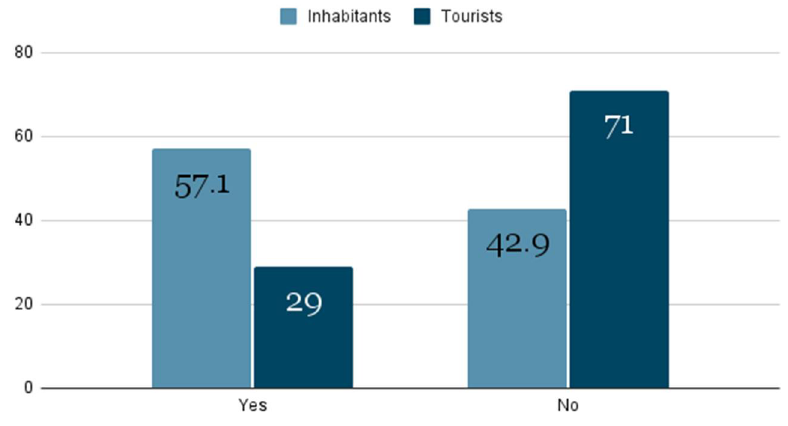
Figure 7. Identification of the Malaga brand. Source: own elaboration.